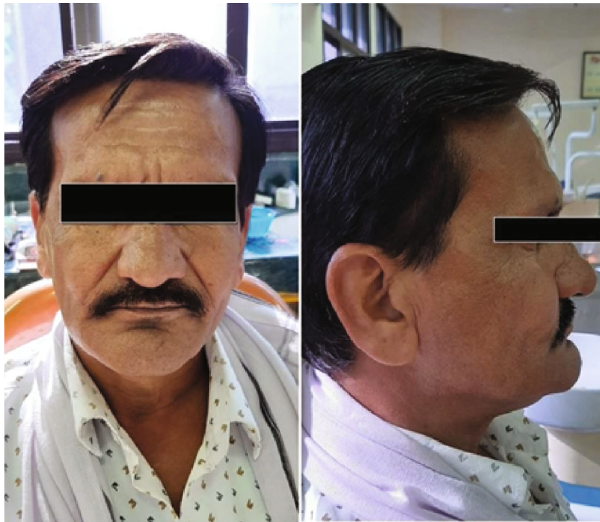
Figure 7: Straight pro fi le and side pro fi le of the patient with maxillary denture and cheek plumper